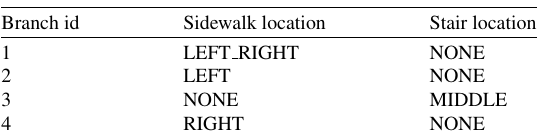
Fig. 12. Crosswalk